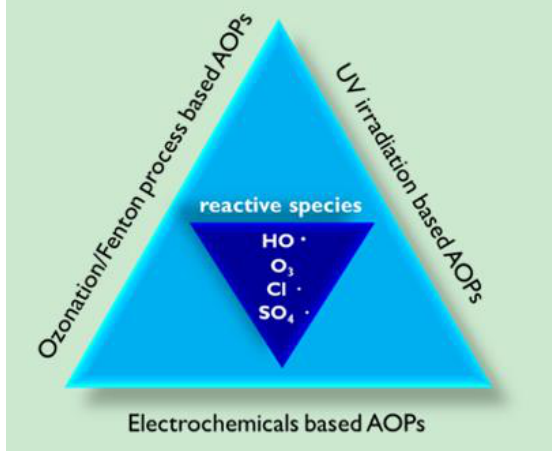
Figure 1. Integrated AOP classification and the reactive species involved. Ultrasonically and hydrodynamically induced cavitation are the two simplest